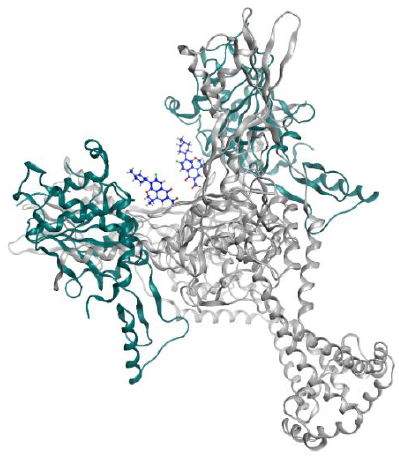
Figure 2. Levofloxacin (blue) in DNA gyrase subunit A (gray ribbon) and subunit B (green ribbon) (PDBID: 5BTI).